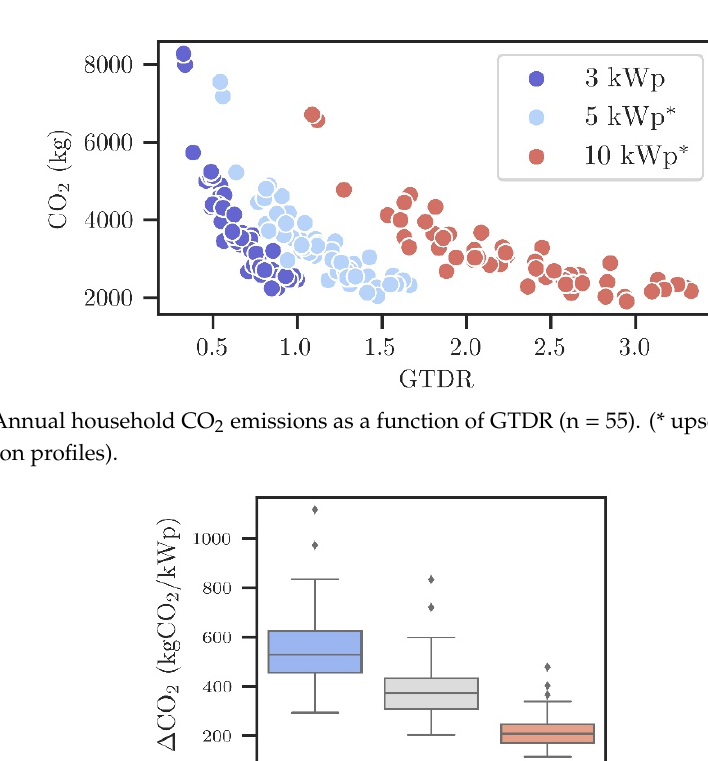
Figure 11. Correlation between annual self-sufficiency and reduction of CO 2 emissions (3 kWp PV).